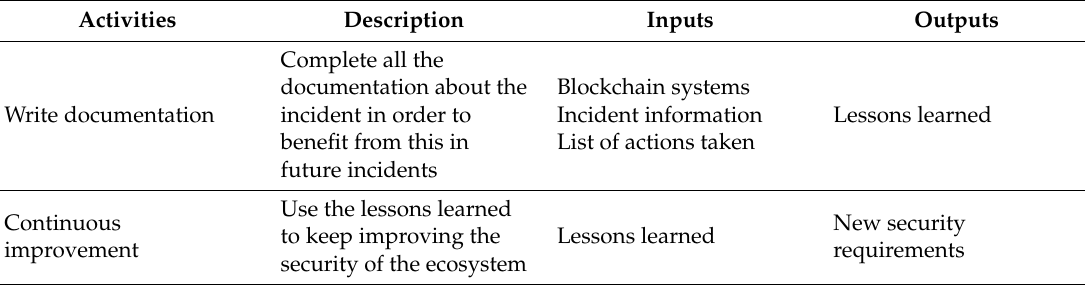
Table 7. Activities of Phase 5: lessons